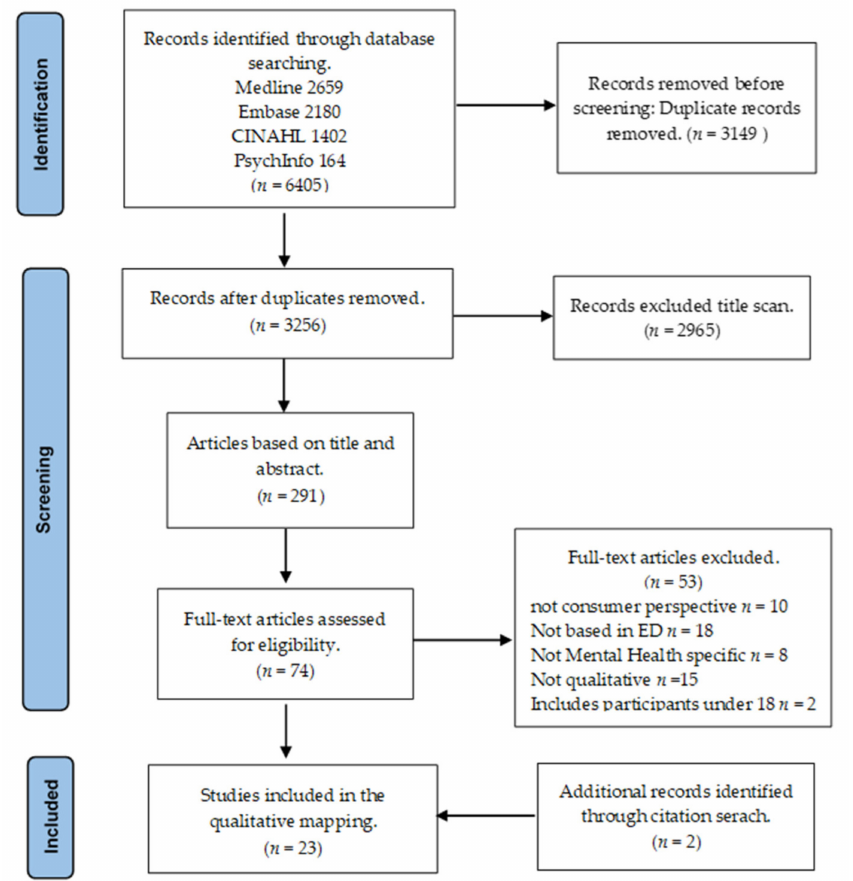
Figure 1. PRISMA flow